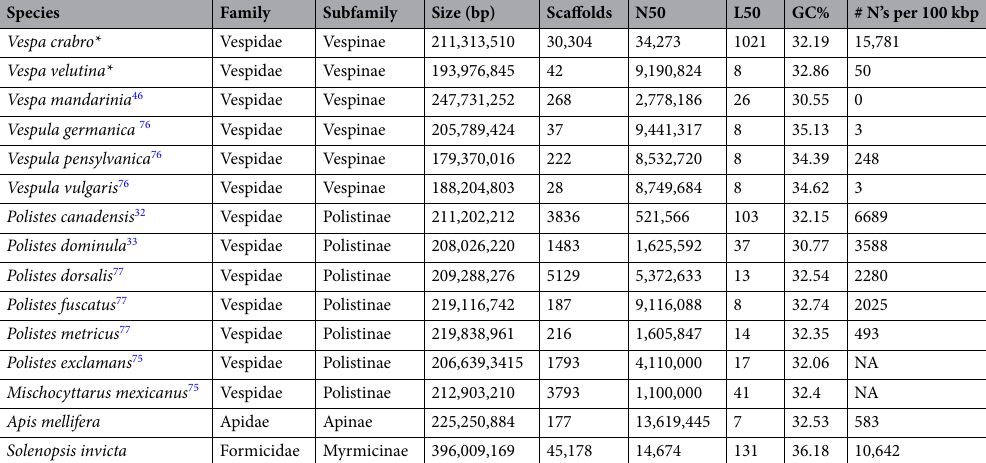
Table 1. Comparison of hornet ( Vespa) genome assemblies statistics with honeybee, fire ant and other social wasp genomes. The three Vespa assemblies (including our two assemblies with the star) with recent wasp genomes and one representative from each ant and bee group. All data in Supplementary Table